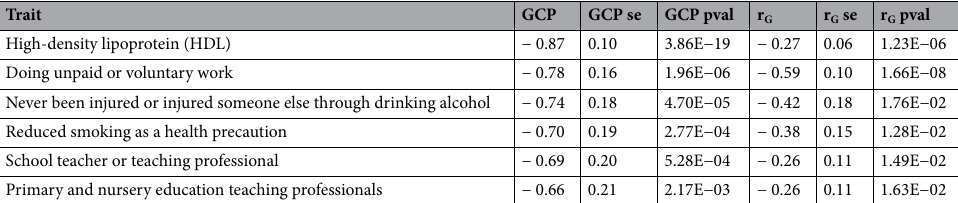
Table 2. Traits with a negative genetic correlation and significant partial causality on ADHD risk. This table shows significant (FDR < 5%) traits with a robust genetic causal proportion (|GCP| > 0.60) and a negative genetic correlation with ADHD. Trait Trait causally associated with ADHD, GCP Genetic causal proportion, GCP se Genetic causal proportion standard deviation, Genetic causal proportion, GCP pval Genetic causal proportion p-value before FDR correction, r G Genetic correlation, r G se Genetic correlation standard deviation, r G p val Genetic correlation p-value before FDR correction. P-values after FDR correction are available for all traits in Supplementary File 1.